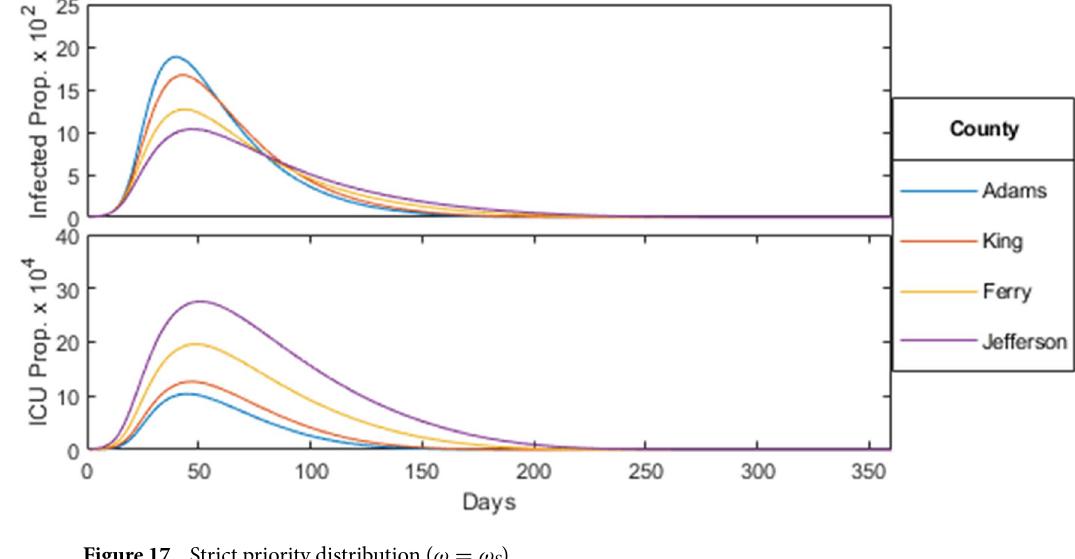
Figure 17. Strict priority distribution ( ω = ω S ).